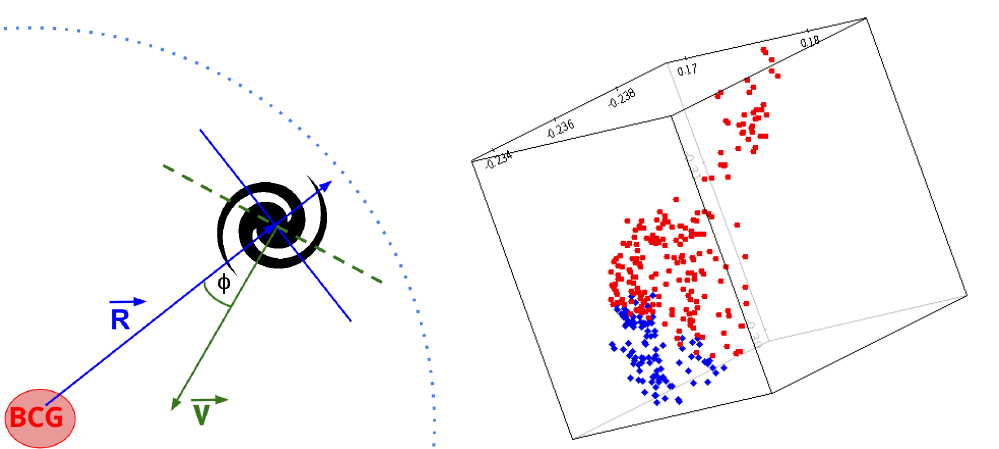
Figure 1. Visualization of EAGLE galaxies. ( Left ): A schematic representation of the vectors and planes used to halve the galaxies. In blue (green) the position (velocity) vector is shown, perpendicular to it the blue solid (green dashed) line schematizes the cut plane of the observational (simulation) case ; ( Right ): Three-dimensional view of an EAGLE galaxy divided in two parts according to the plane perpendicular to the velocity vector measured with respect to the position of the brightest cluster galaxy (BCG). Blue diamonds belong to the leading part, while the red dots correspond to the trailing half. The unit of each side of the cube is